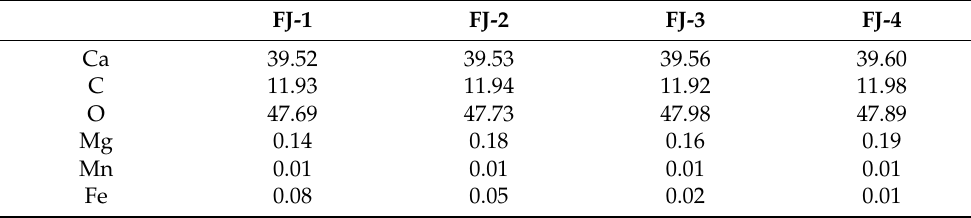
Table A2. Chemical compositions of analyzed calcite from Fujian analyzed by Micro-XRF (in